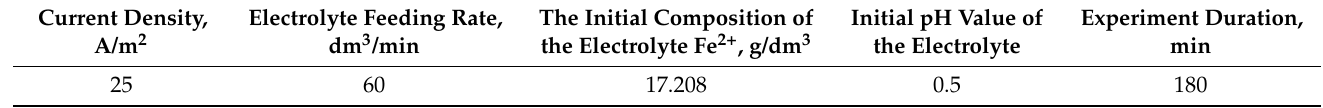
Table 2. Average indicators for carrying out the electrooxidation process.